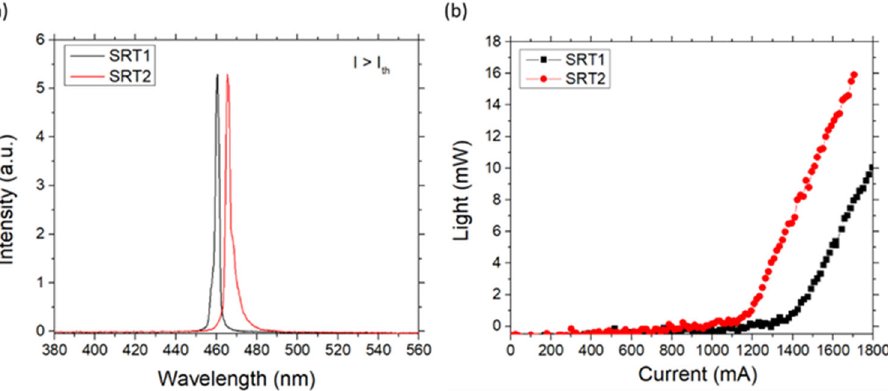
Figure 3. ( a ) EL spectrum showing the lasing peak at 460.5 and 465.29 nm for SRT1 and SRT2, respectively. ( b ) Single facet L-I characteristics of SRT1 and SRT2.